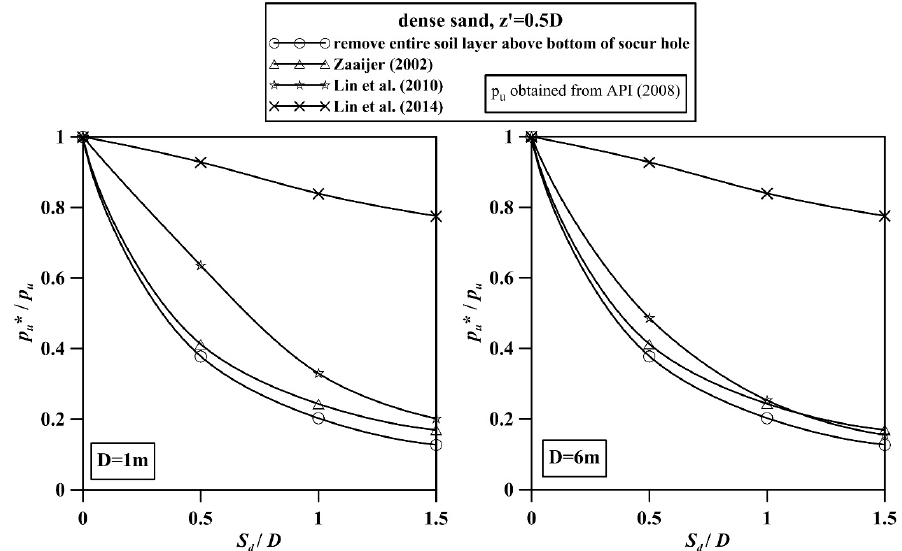
Figure 5. Relationship between the ultimate soil resistance at depth of 0.5 D below the bottom of the scour hole and the scour depth.